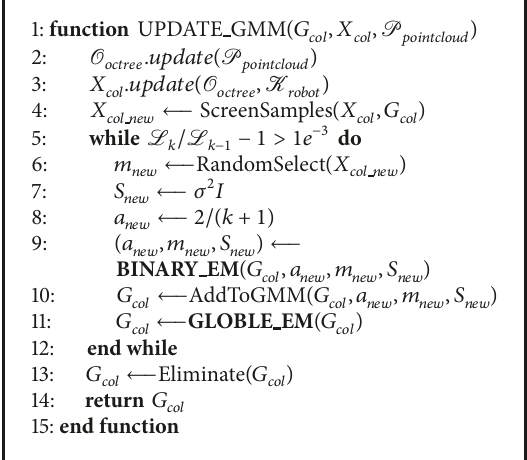
Figure 5: GMM’s training